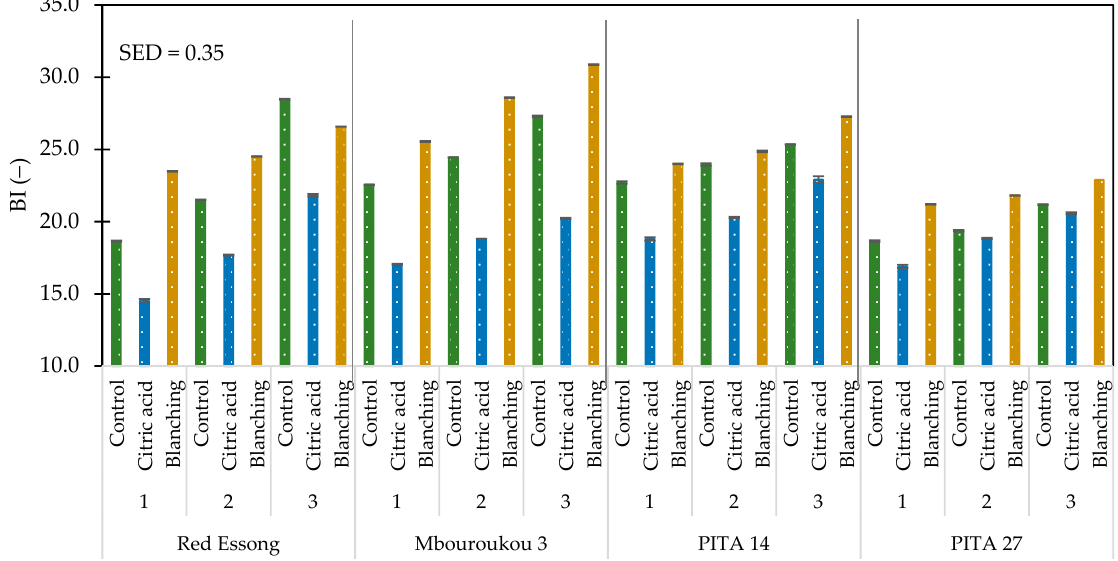
Figure 5. Browning index of plantain flours as influenced by cultivar, ripening stages, and pre-treatment methods. Ripening stage: 1 = mature green; 2 = green with a trace of yellow; and 3 = more green than yellow.